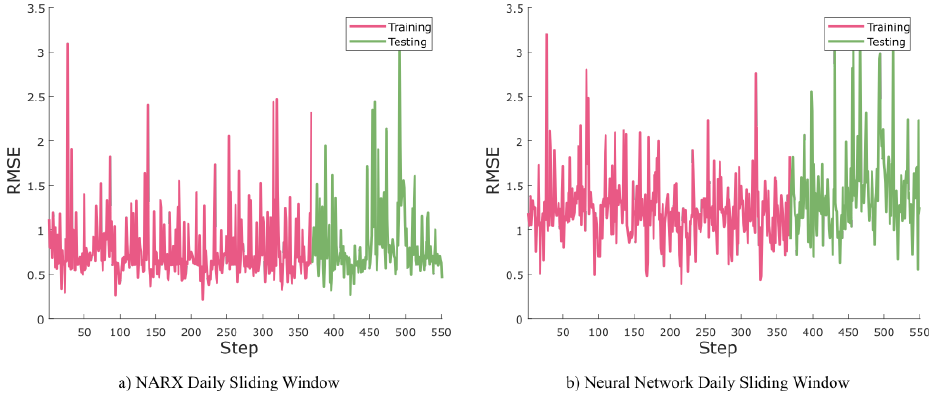
Figure 10. Comparison between the daily moving window RMSE for the NARX and NN models with 12 months of training data and 10 min time resolution, for Case